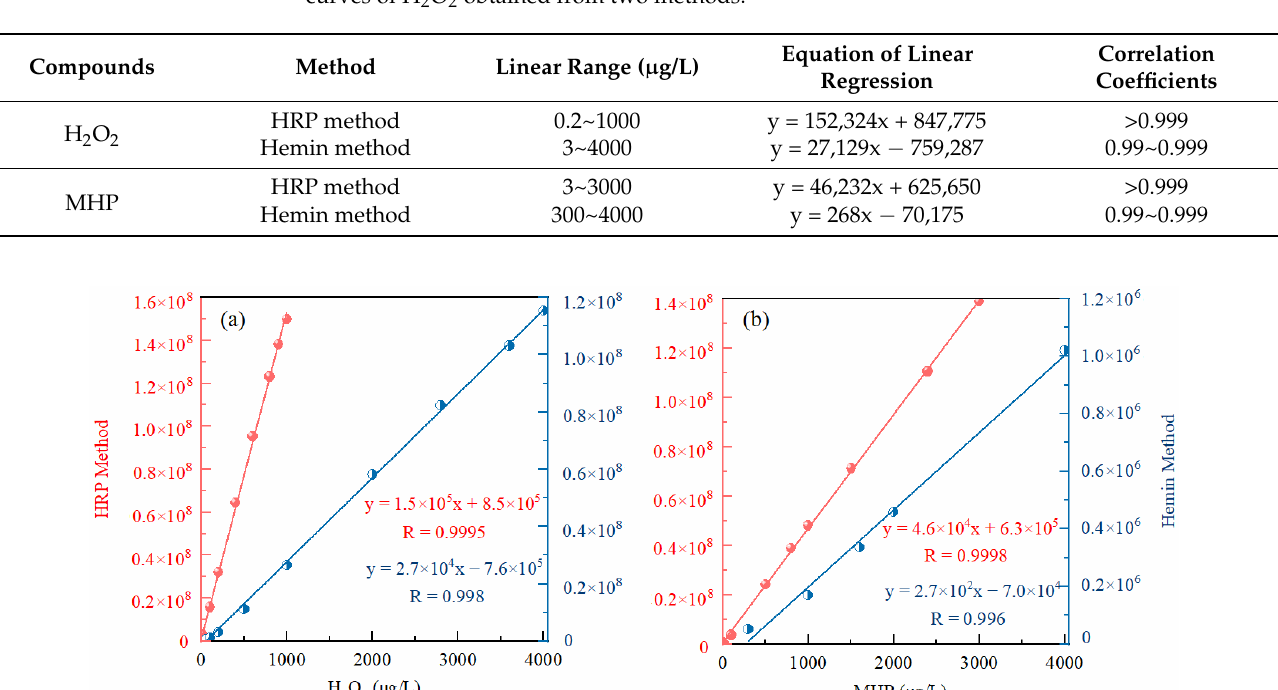
Table 2. The linear range, equation of linear regression, and correlation coefficients of calibration curves of H 2 O 2 obtained from two methods.